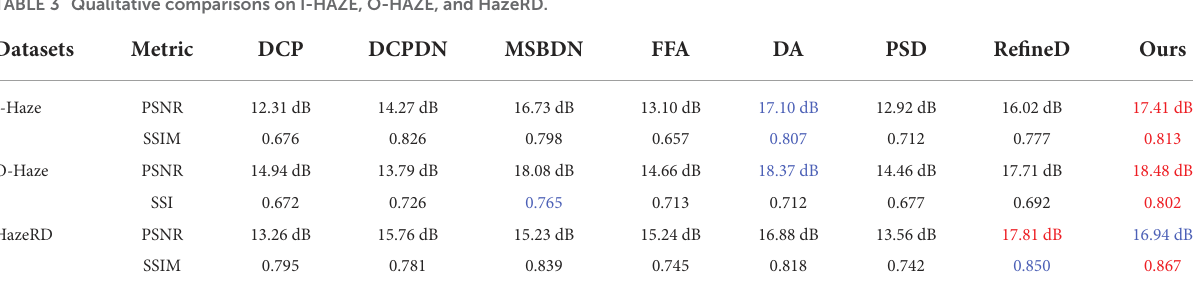
TABLE 3 Qualitative comparisons on I-HAZE, O-HAZE, and HazeRD.